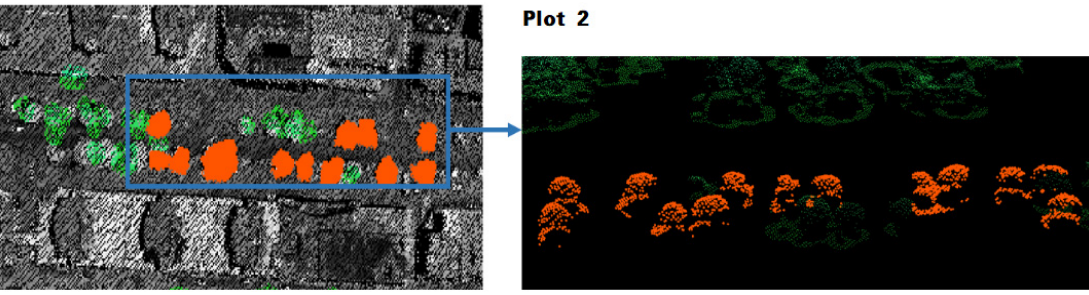
Remote Sens. 2021 , 13 , 3428 Figure 8. The edges of the building that were mistakenly extracted as trees are shown as red points.